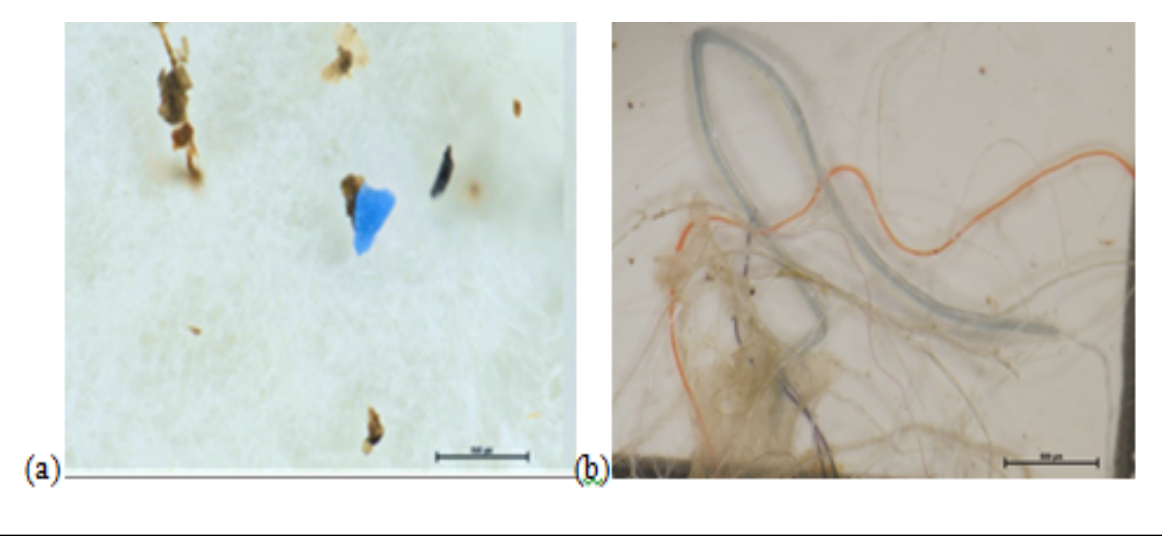
Figure 6: Examples of microplastic types by shape recovered from fish tissues: (a) Blue fragment from the gut of R. kanagurta of Fort Jesus (b) Red, blue and black tangled fibers from the gills of G. oyena of Makupa